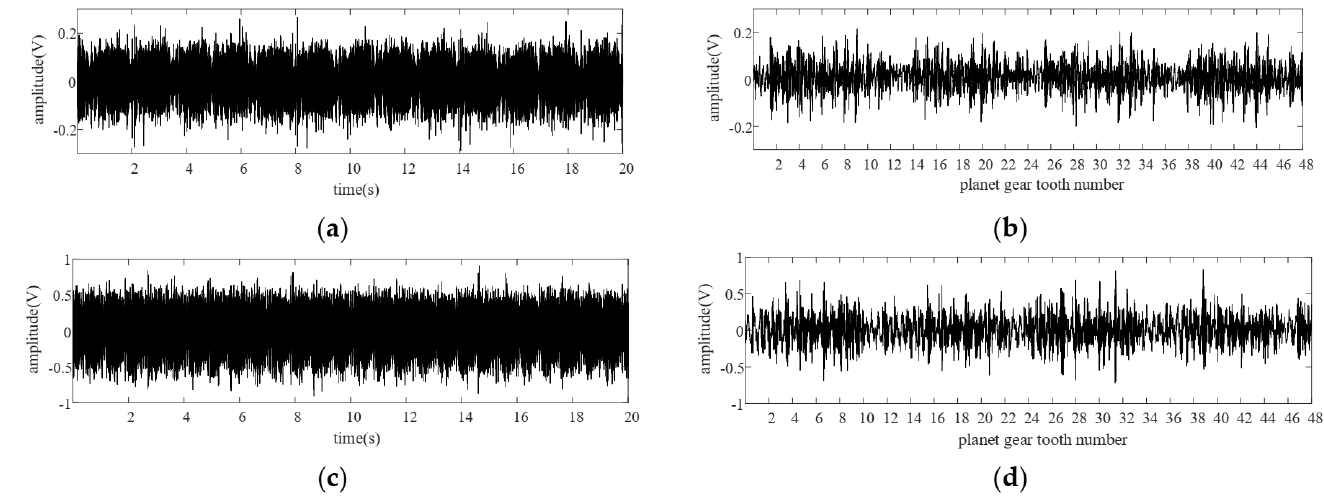
Figure 11. Vibration signal and the resultant TVTF-VS waveform: ( a ) vibration signal under 400 rpm, ( b ) TVTF-VS waveform under 400 rpm, ( c ) vibration signal under 800 rpm, ( d ) TVTF-VS waveform under 800 rpm.